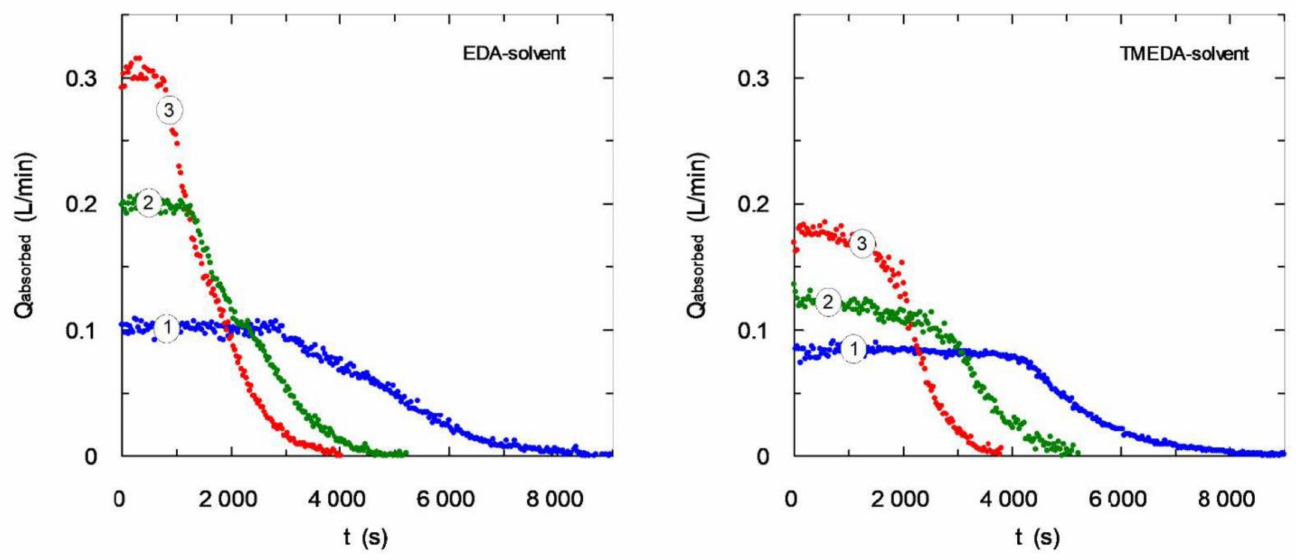
Figure 8. Influence of gas flow-rate fed to bubble column using EDA- and TMEDA-based solvents. C B = 0.3 mol · L − 1 (0.6 mol · L − 1 of amine centers) ( 1 (cid:13) ) Q G = 0.1 L · min − 1 ; ( 2 (cid:13) ) Q G = 0.2 L · min − 1 ; ( 3 (cid:13) ) Q G = 0.3 L · min − 1